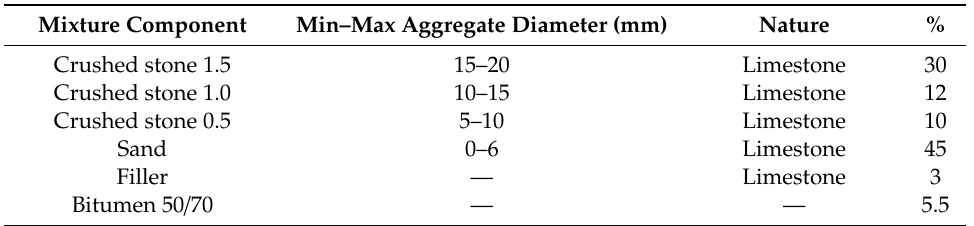
Table 1. Asphalt mixture mix design.